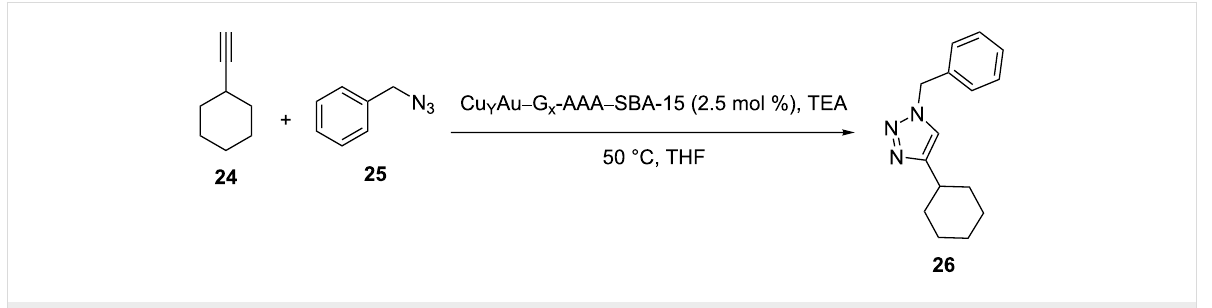
Scheme 3: Synthetic route of dendrons, illustrated using G 2 -AMP 23